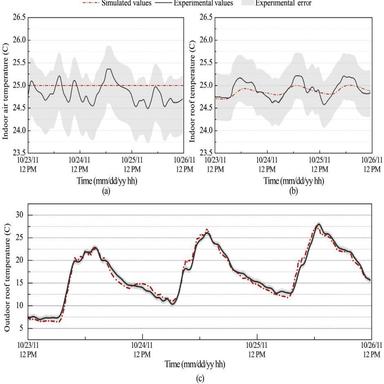
Dark (α = 0.15), thermochromic (α = − 0.35 0.55) and cool (α = 0.55) external roof surface temperature (TR), outward sensible heat flux (HR) and inward heat flux (QinR) monthly-averaged diurnal cycles for the six spring and summer months.